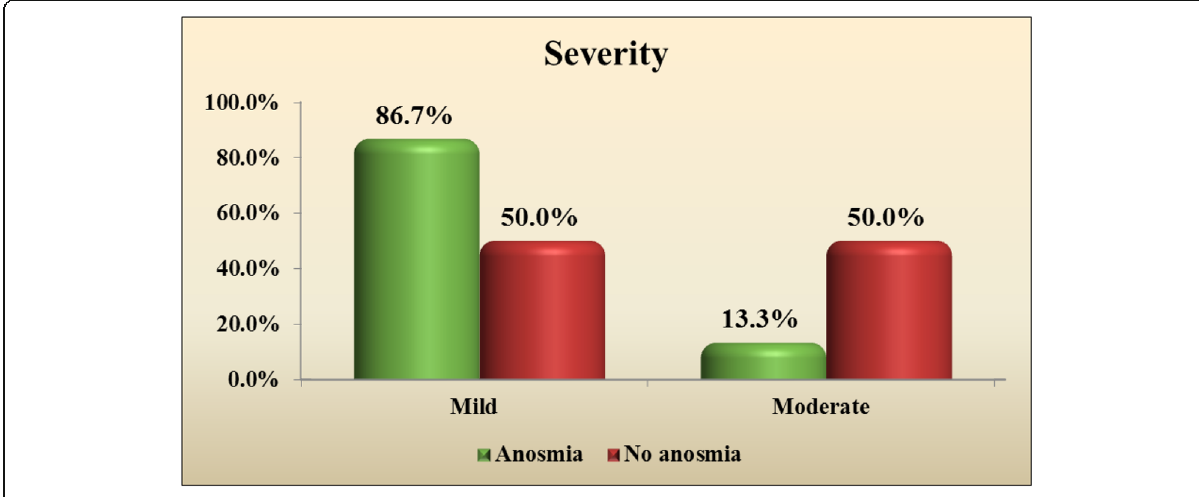
Fig. 1 Clinical severity in anosmia and non-anosmia